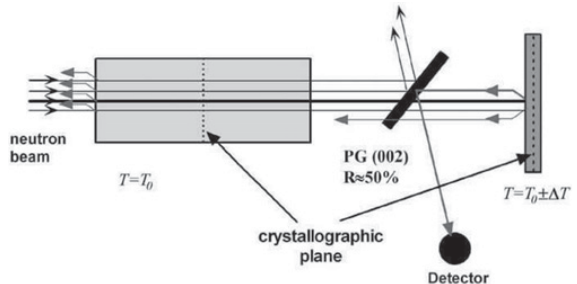
Figure 1. Scheme of the experiment to search for the neutron EDM